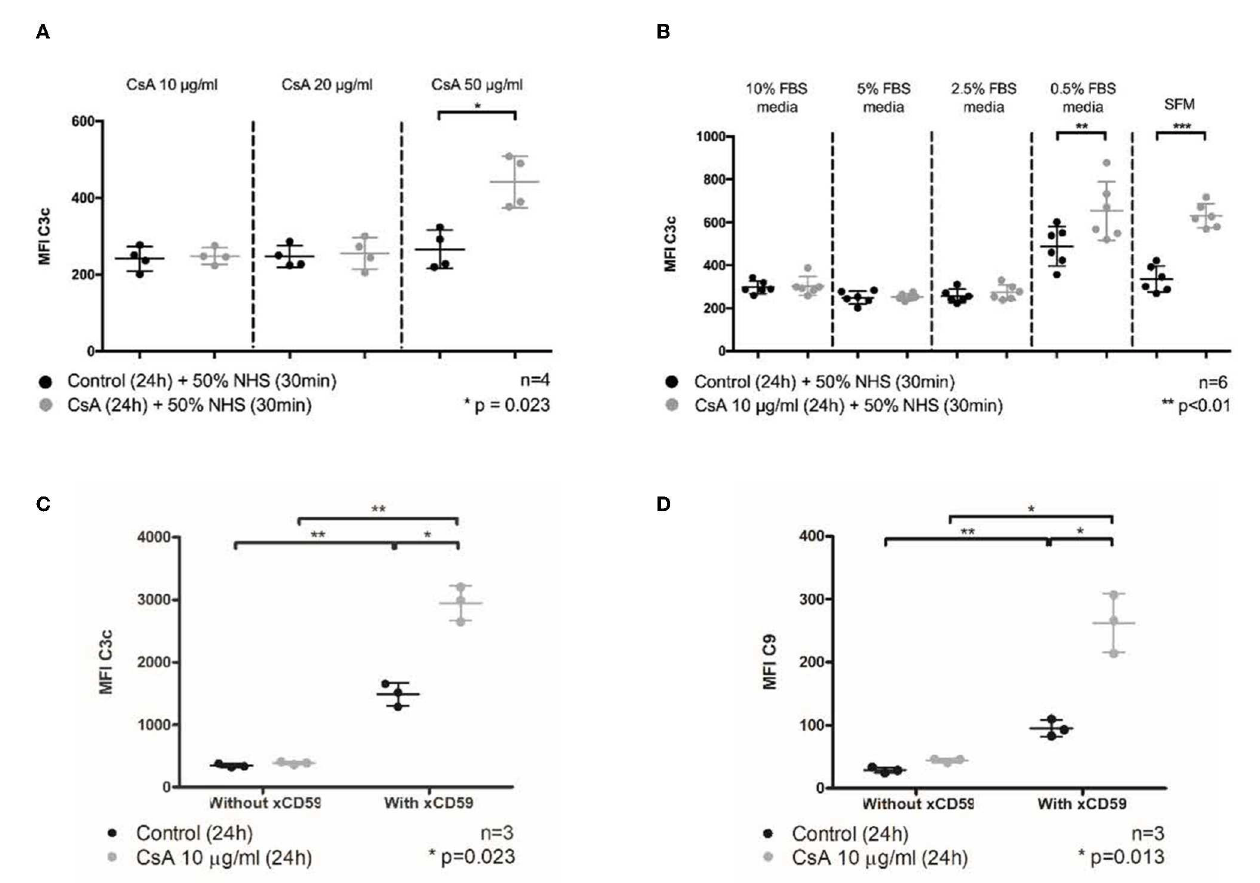
FIGURE1 Cyclosporine causes complement deposition on endothelial cell surfaces, enhanced by serum starvation and anti-CD59 sensitization. Blood outgrowth endothelial cells (BOECs) were incubated in cyclosporine (CsA) for 24h, followed by 50% NHS for 30min. Unless specified, cyclosporine was reconstituted with media/10% FBS. C3c and C9 deposition on BOEC surfaces was detected by flow cytometry. Non-viable cells were excluded from analysis with Fixable Viability Dye eFluor 780. (A) Incubating BOECs with cyclosporine 50 µ g/ml resulted in significantly higher C3c deposition ( n = 4, p = 0.023, paired, two-tailed t -test). (B) Incubating BOECs with cyclosporine 10 µ g/ml reconstituted in media supplemented with decreasing amounts of FBS resulted in significantly higher C3c deposition ( n = 6, p < 0.01, paired, two-tailed t -test). (C) Addition of anti-CD59 antibody